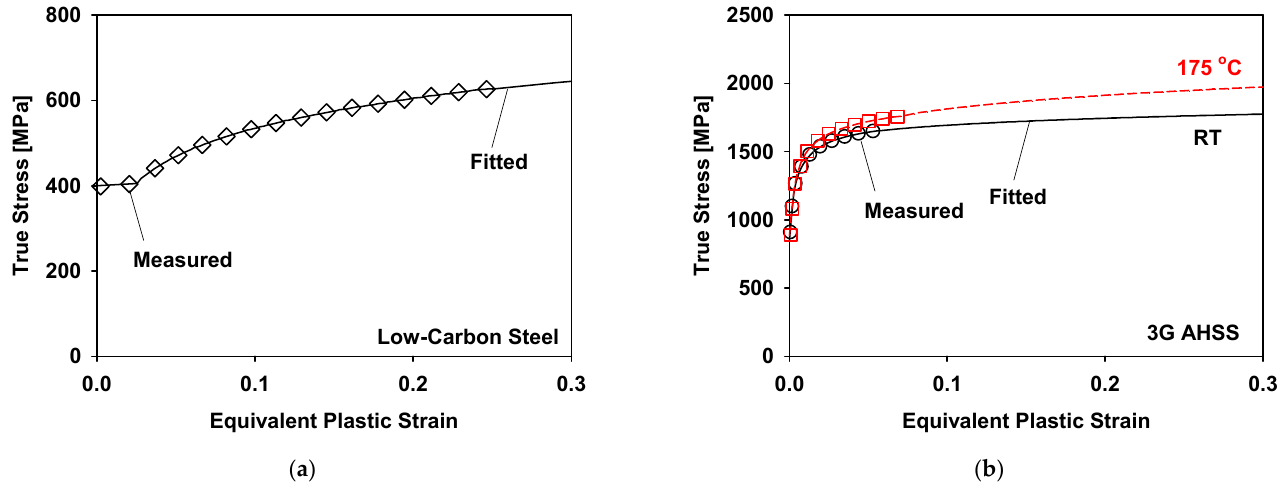
Figure 6. Flow stress–equivalent plastic strain curves of the sheet materials: ( a ) low-carbon steel and ( b ) 3G AHSS. Table 2. Tensile properties and hardening parameters.